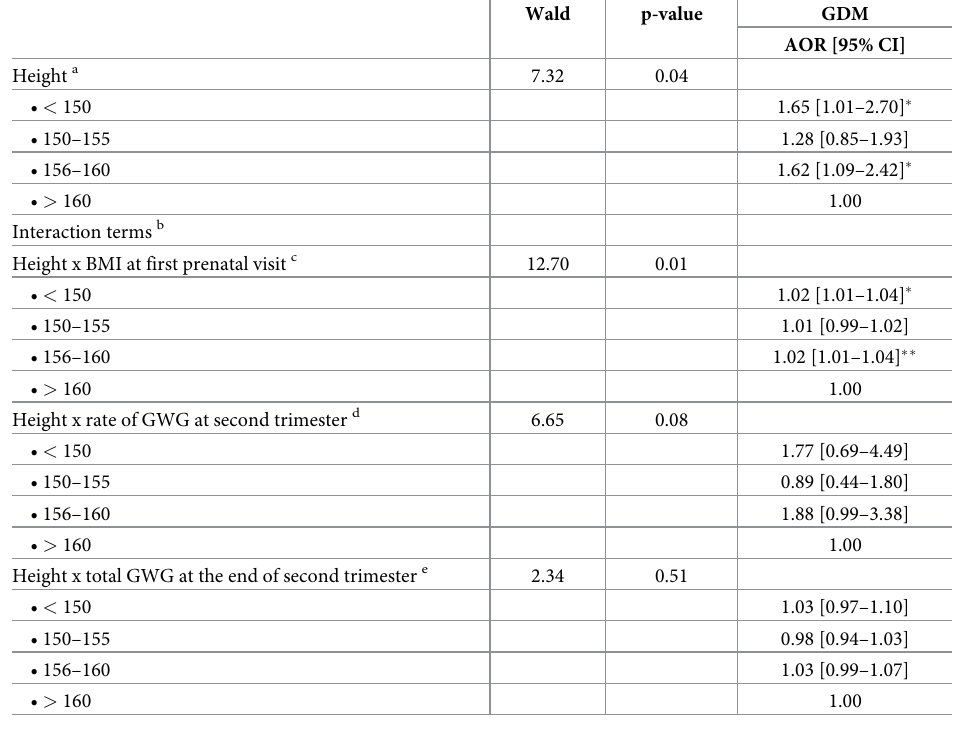
Table 3. Adjusted odds ratio (OR) and 95% confidence intervals (95% CI) for associations between height and gestational diabetes mellitus (GDM) (n = 1945).